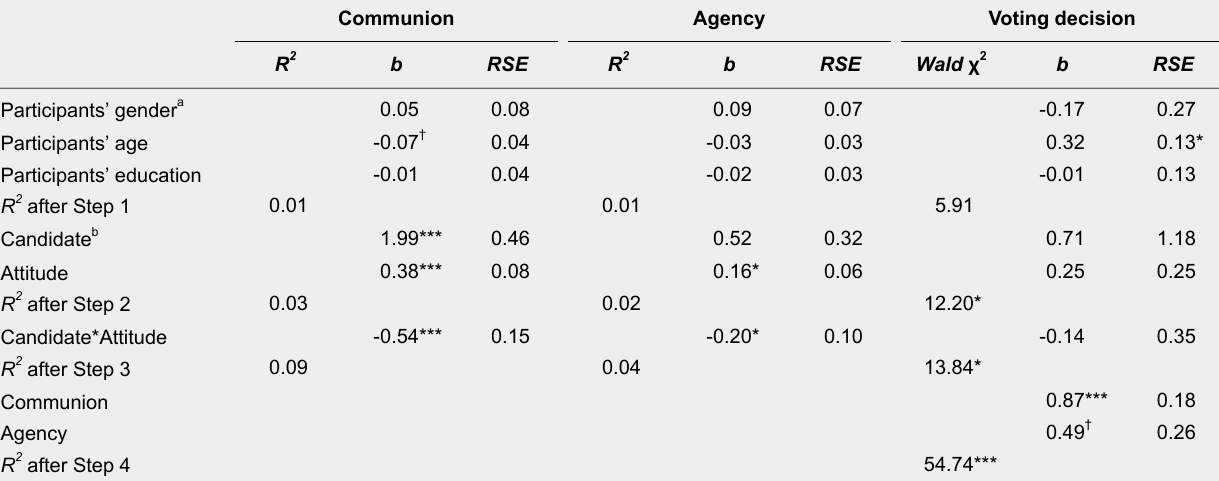
Regression-Based Moderations and Moderated Mediation in Study 2